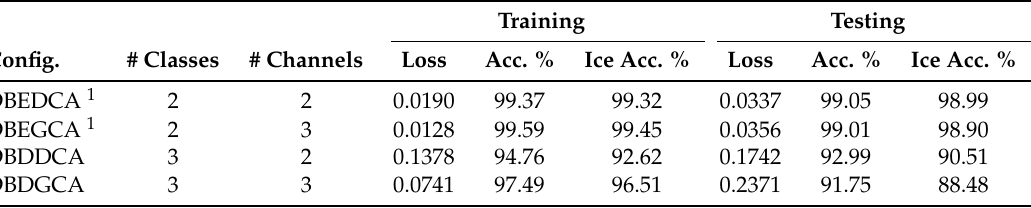
Table 3. U-Net based classifier results.